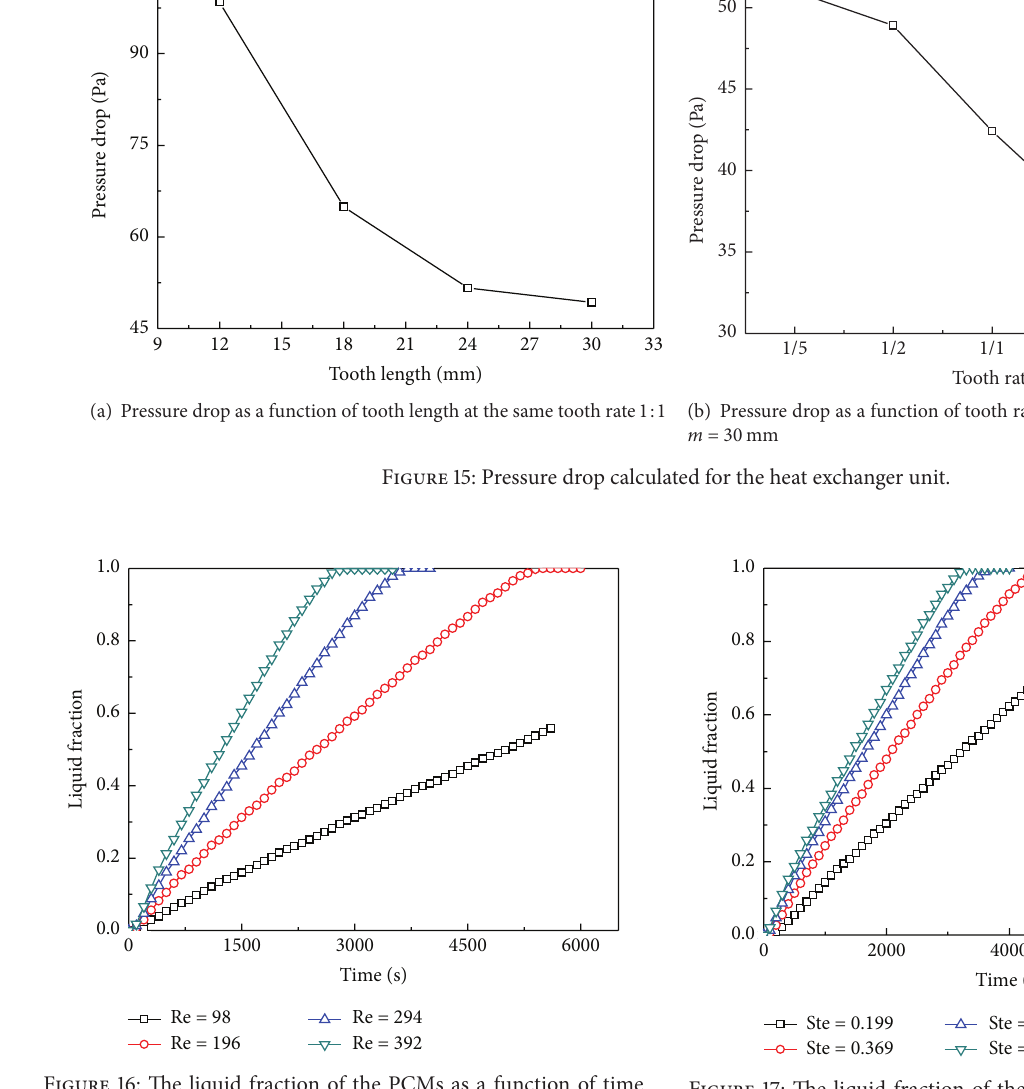
Figure 17: The liquid fraction of the PCMs as a function of time during the charging process at different Ste